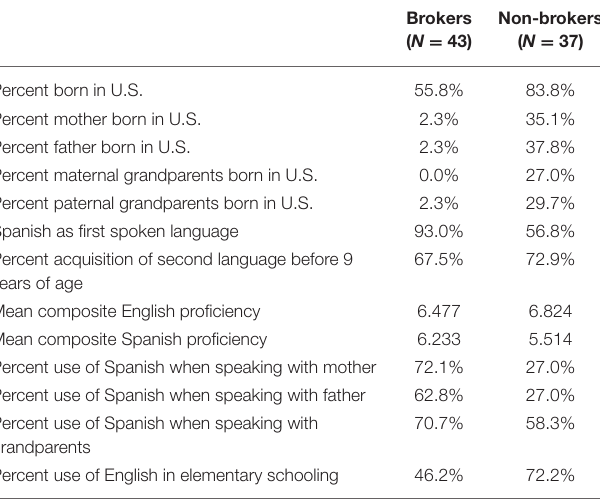
TABLE 1 | Broker and non-broker language profile.